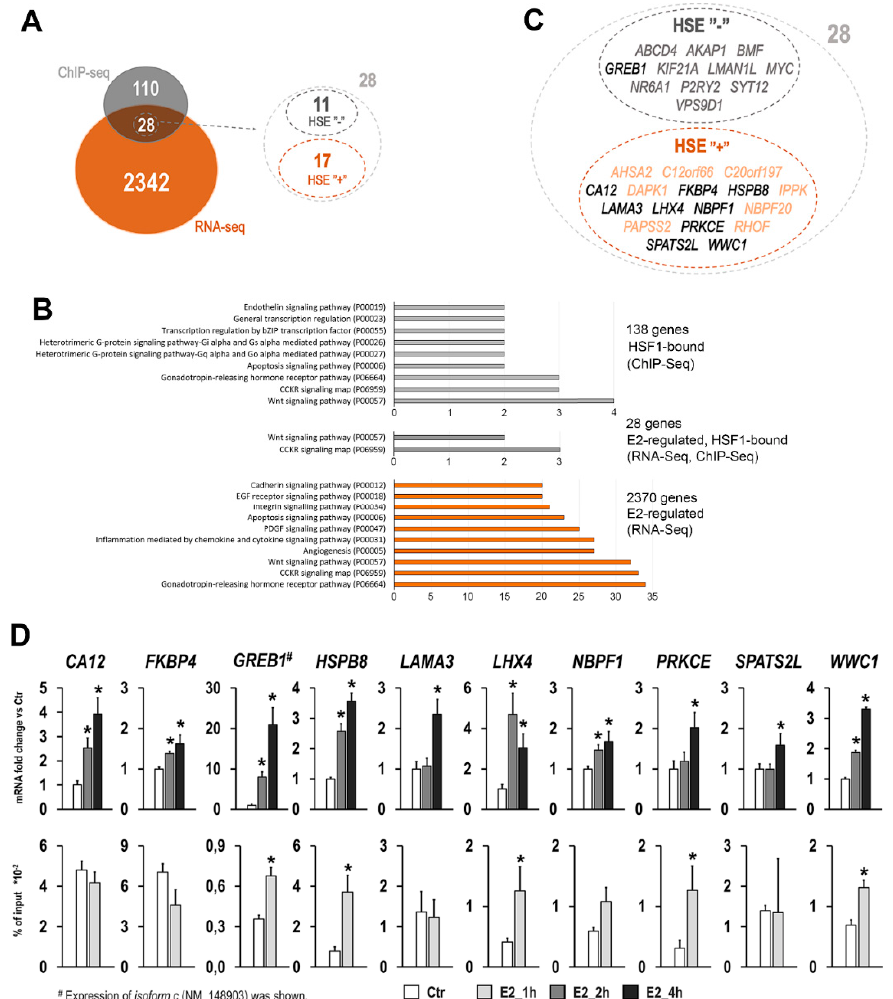
Figure 5. Identification of genes affected by E2-treatment potentially regulated by HSF1 in MCF7 cells. ( A ) A number of genes with E2-induced binding of HSF1 in their regulatory region (identified by ChIP-Seq) and / or altered expression profile (identified by RNA-Seq). To find HSE motifs and to identify genes directly regulated by HSF1, the detailed analysis within the ChIP-Seq-detected peaks was performed. ( B ) Gene ontology analyses showing numbers of genes in pathways from the PANTHER classification system. In the case of gene sets selected in ChIP-Seq (138 or 28 genes), only pathways with more than two genes are shown. In the case of all E2-regulated genes, only ten pathways with the highest number of genes are shown. ( C ) List of 28 E2-regulated genes with and without HSE motifs in their regulatory regions. Bolded symbols indicate the genes selected for further validation experiments. ( D ) Validation analysis for ten selected genes. Gene expression (upper row) and binding of HSF1 to detected HSE sequences in regulatory regions (bottom row) were analyzed by qPCR. Asterisks indicate the statistical significance of differences ( p < 0.05) between control and test samples.